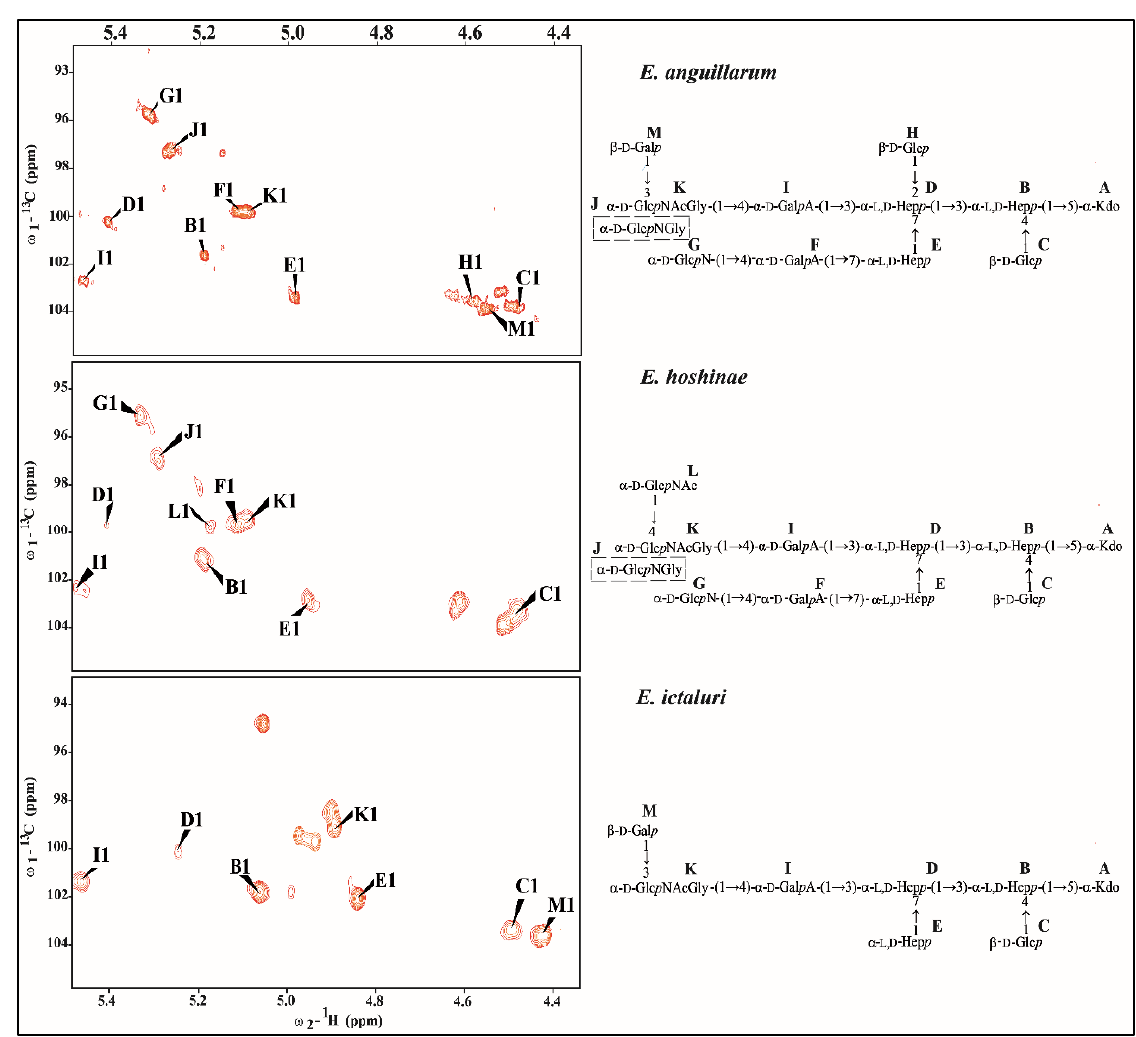
Figure 6. Anomeric regions of 1 H − 13 C HSQC ‐ DEPT spectra of E. anguillarum 205/03 , E. hoshinae DSMZ 13771 T and E. ictaluri AL ‐ 15 ‐ 01 ‐ CATFISH core